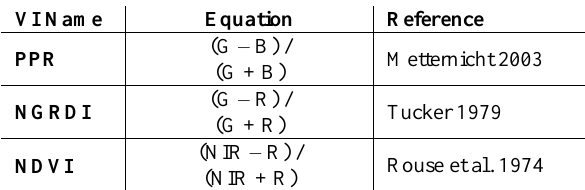
Table 2. Vegetation indices used in this study. B = blue band, G = green band, R = red band, NIR = near infrared band.